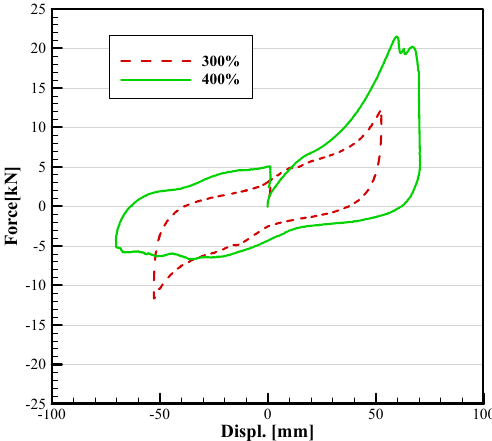
Figure 4. Hysteresis curve for OPT1 shear test.